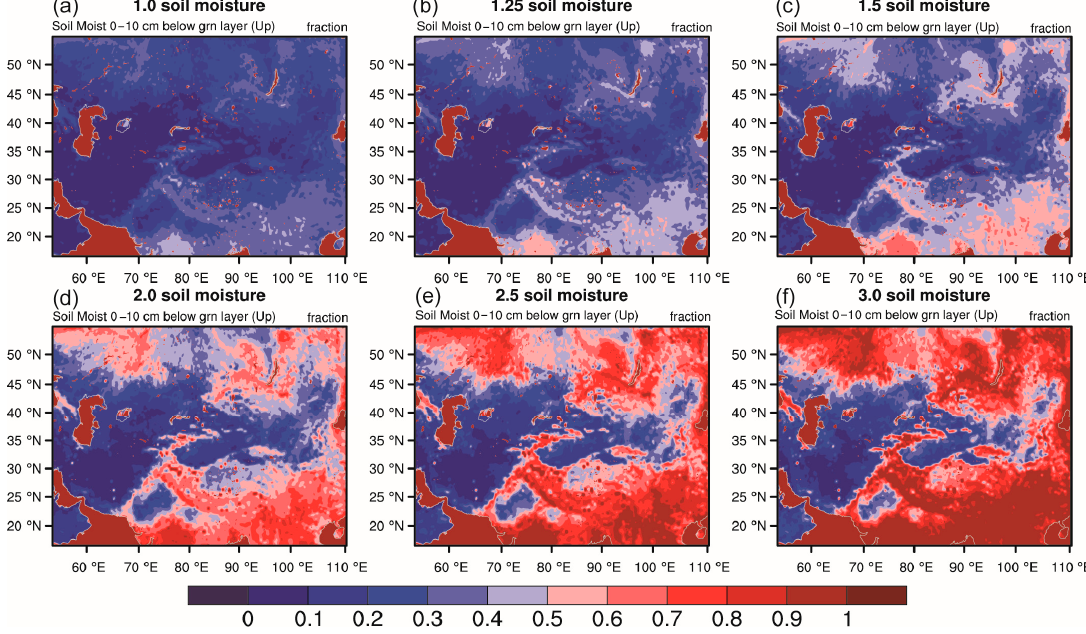
Figure 2. The soil moisture contents of 10–cm topsoil layer of the Noah land surface model (LSM) of six WRF simulations: ( a ) 1.0 multiple of National Centers for Environmental Prediction (NCEP) Global Forecast System (GFS) soil moisture; ( b ) 1.25 multiples of NCEP GFS soil moisture; ( c ) 1.5 multiples of NCEP GFS soil moisture; ( d ) 2.0 multiples of NCEP GFS soil moisture; ( e ) 2.5 multiples of NCEP GFS soil moisture; and ( f ) 3.0 multiples of NCEP GFS soil moisture.